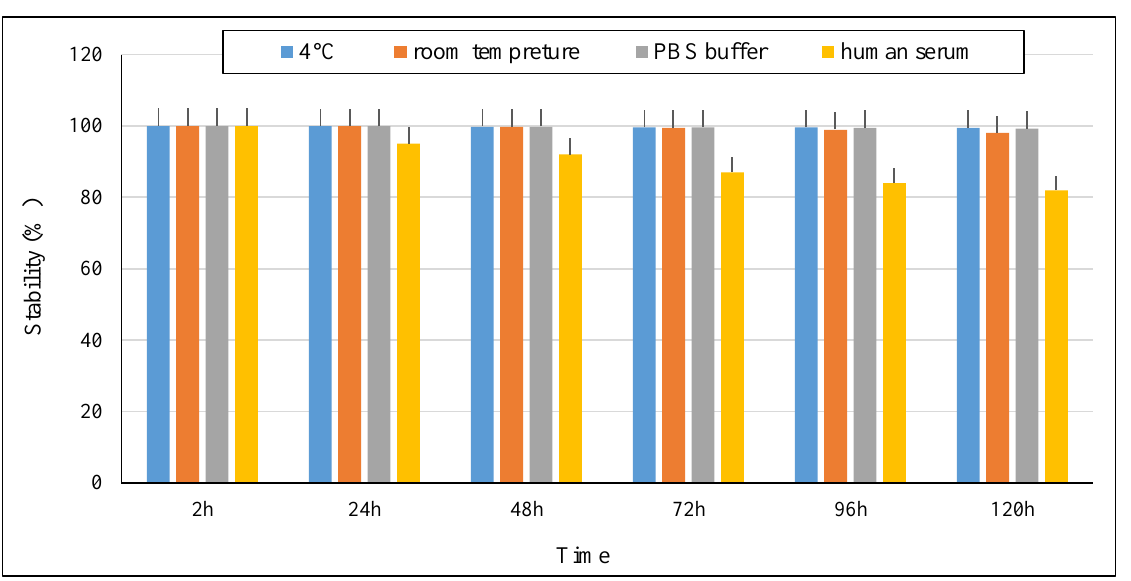
Figure 2. In vitro stability of radiolabeled avastin after storing at various conditions for different times.